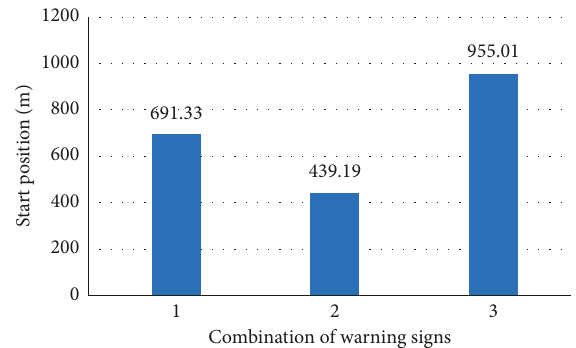
Figure 5: Mean value of start position under different combinations of sign schemes. Table 5: Results of descriptive statistical analysis of speed at the start of a lane change and analysis of variance